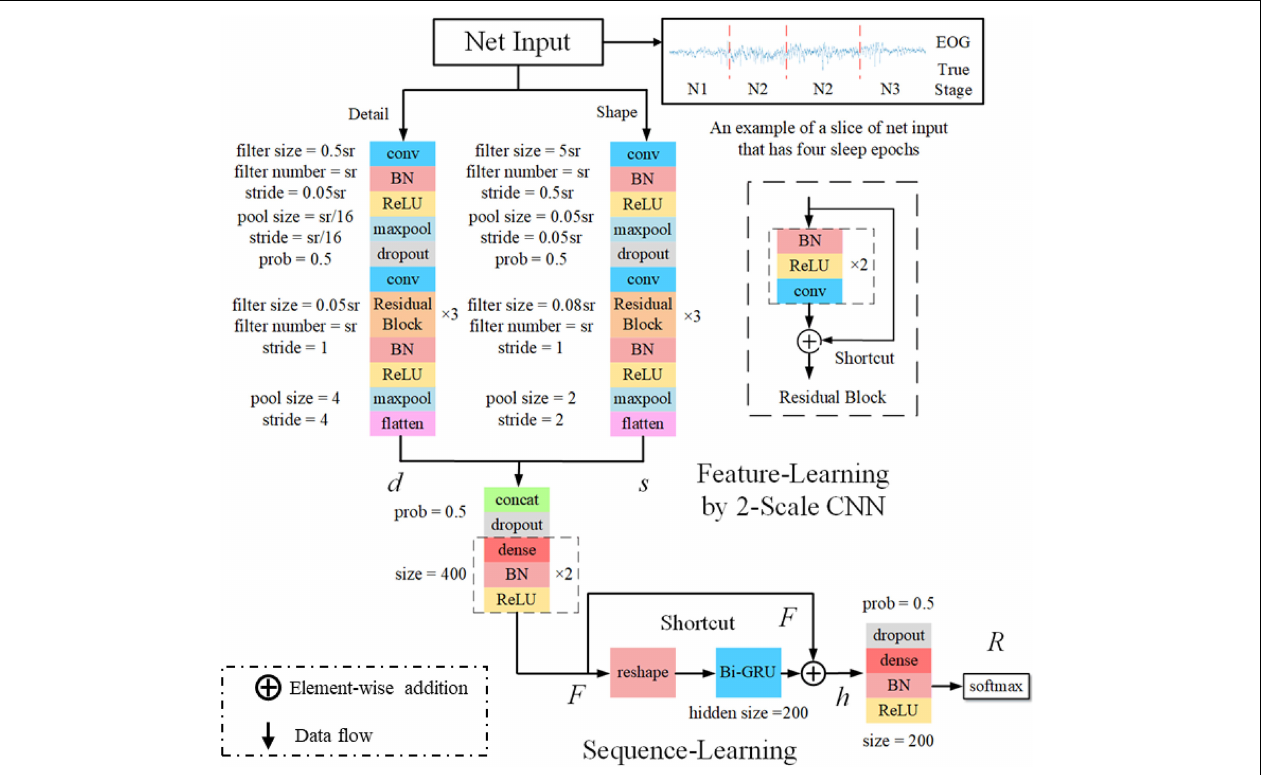
FIGURE 3 | The architecture of the proposed network. sr, sampling rate of the input signals; conv, convolutional blocks; BN, batch normalization; ReLu, the rectified linear unit; d and s , features learned by feature learning parts; F , integrated features; h , the output of Bi-GRU; R , the predicted probabilities by the